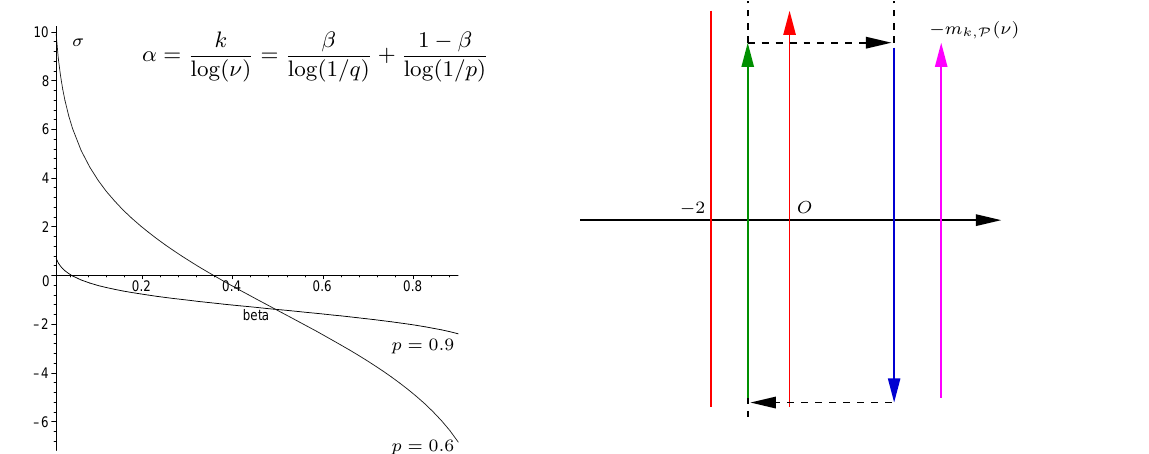
Fig. 2: The saddle-point σ as a function of β , where β is a barycentric weight varying from 0 to 1. The curves correspond to p = 0 . 6 and p = 0 . 9